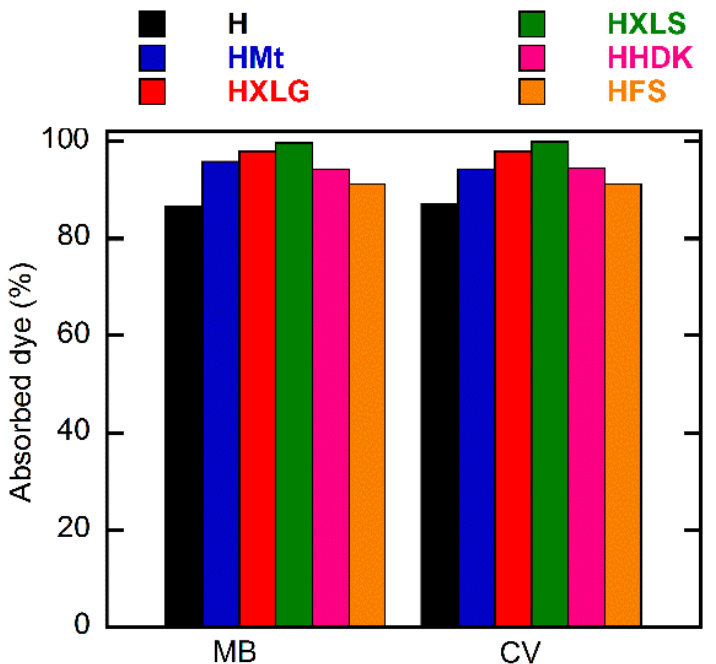
Figure 9. Dependence of the percentage of dye absorbed on reinforcing agent. Initial dye concentra- tion = 20 mg/L; xerogel amount = 0.003 g; dye solution volume = 30 mL; temperature = 25 ± 0.5 °C; time = 30 h.